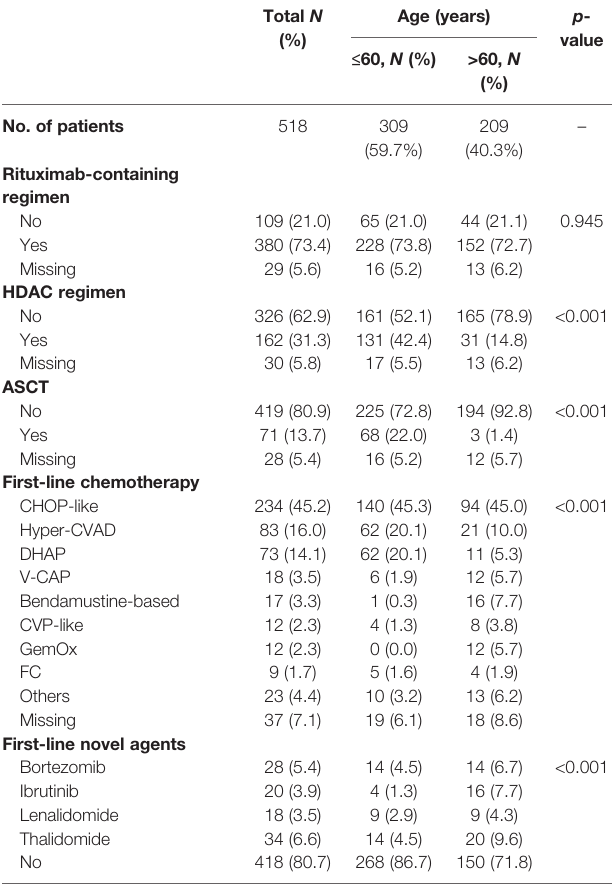
TABLE 2 | Treatment summary in different age